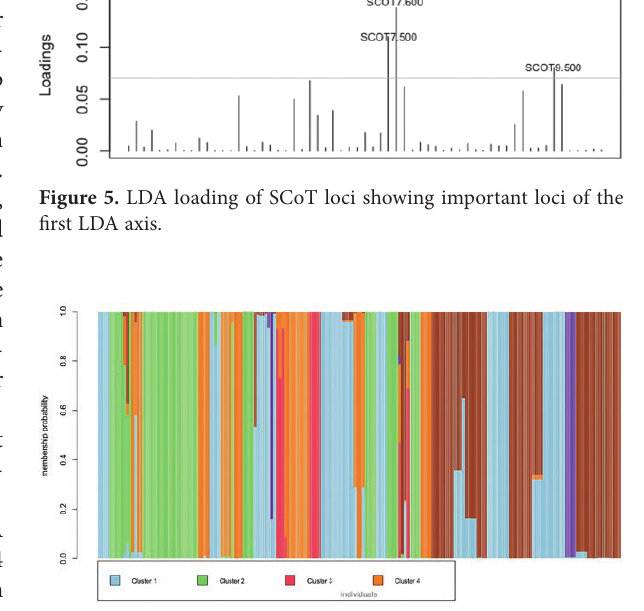
Figure 6. Assignment plot of Punica genotypes based on SCoT markers. Similarly colored individuals have similar genetic content, while admixed colors. indicated gene flow or ancestral shared